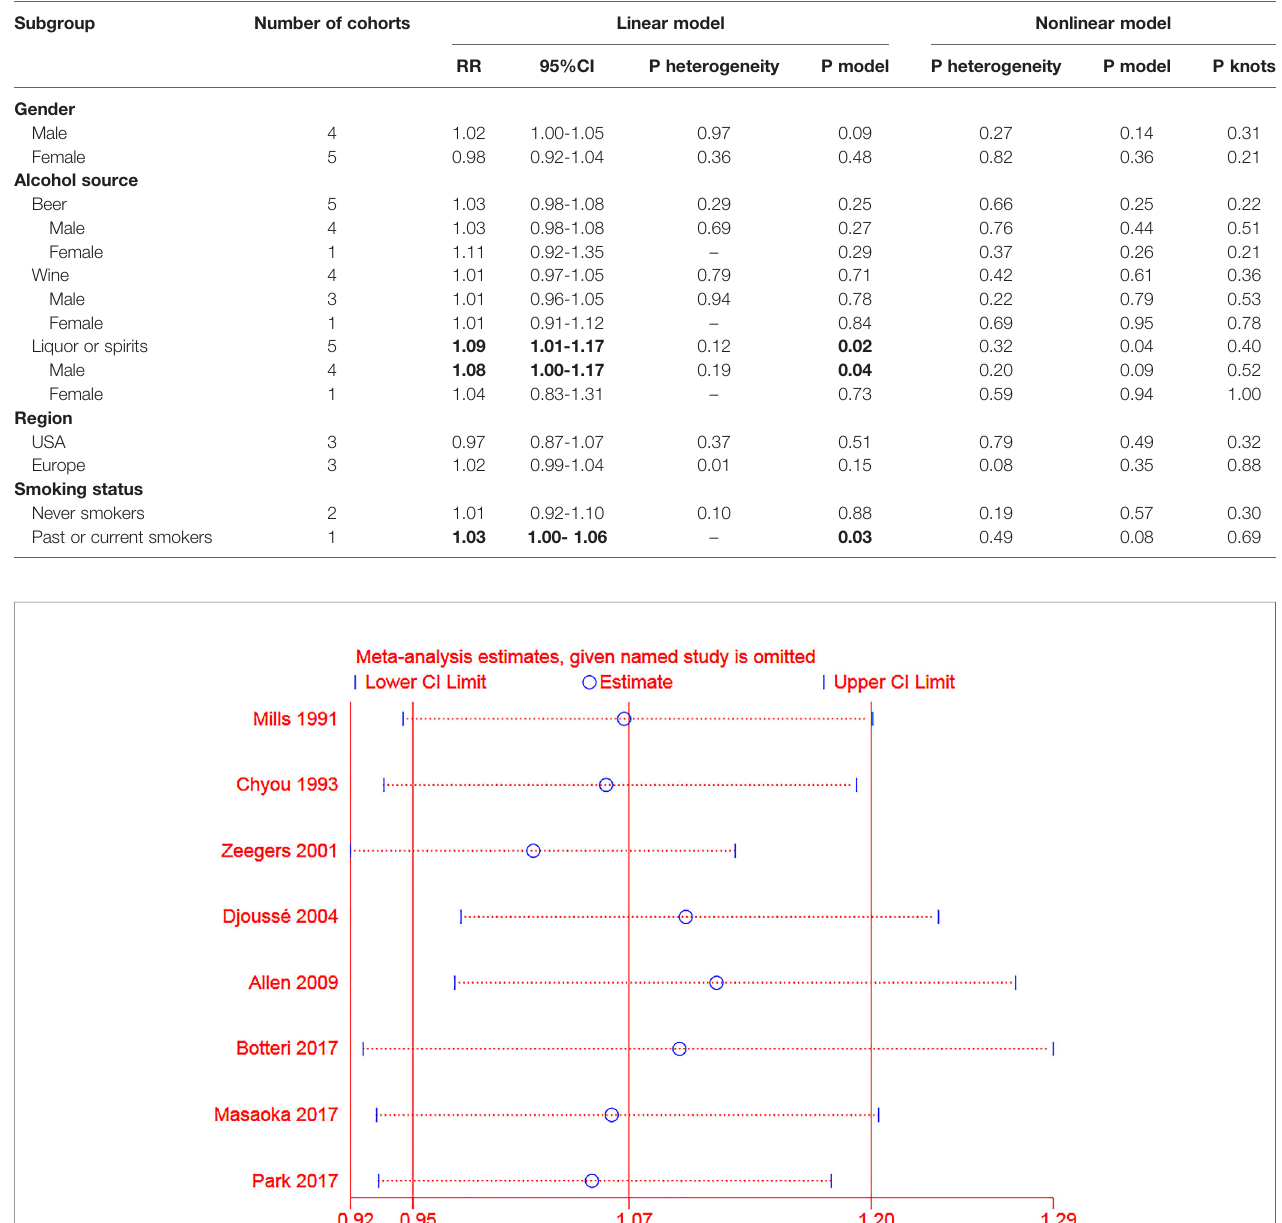
TABLE 2 | Summary of subgroup analysis results based on fi xed-effect linear and nonlinear (3 knots) dose-response meta-analysis. Bold values mean results with statistical signi fi cance.